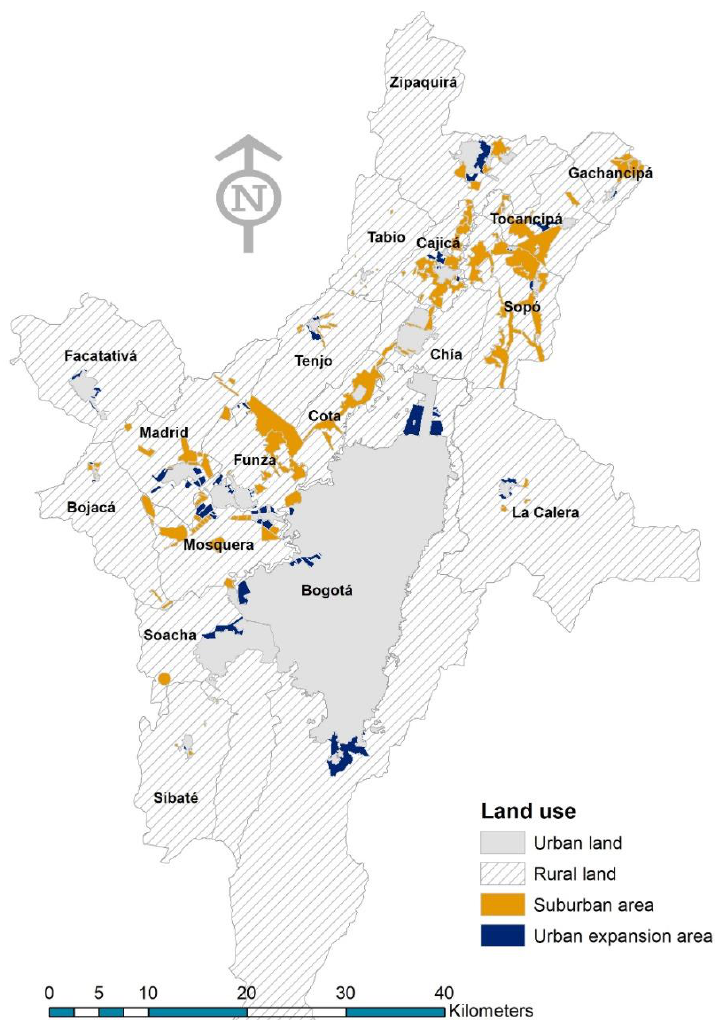
Figure 1. Current land classification. Based on information from [57].